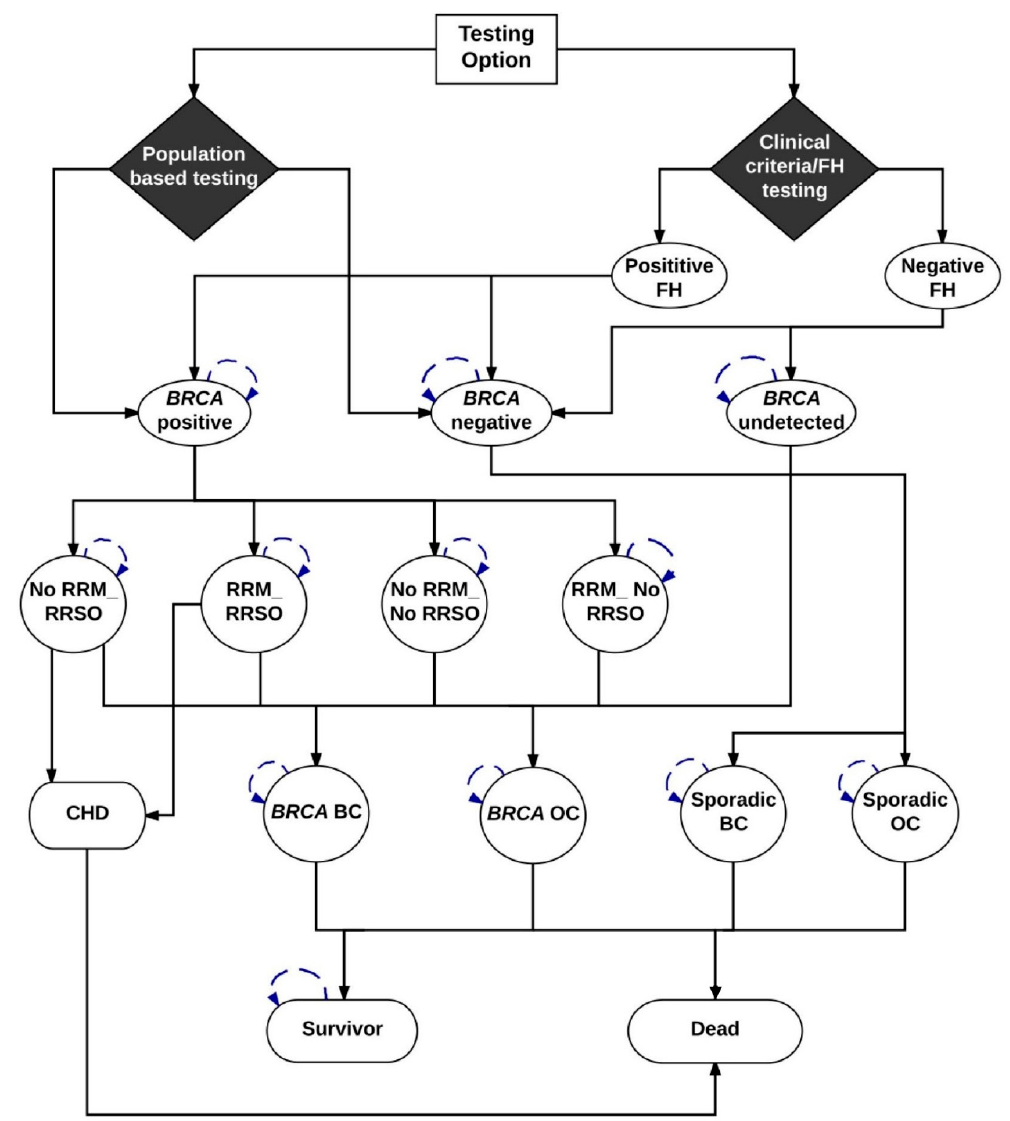
Figure 3. BC, breast cancer; CHD, coronary heart disease; FH, family history; OC, ovarian cancer;